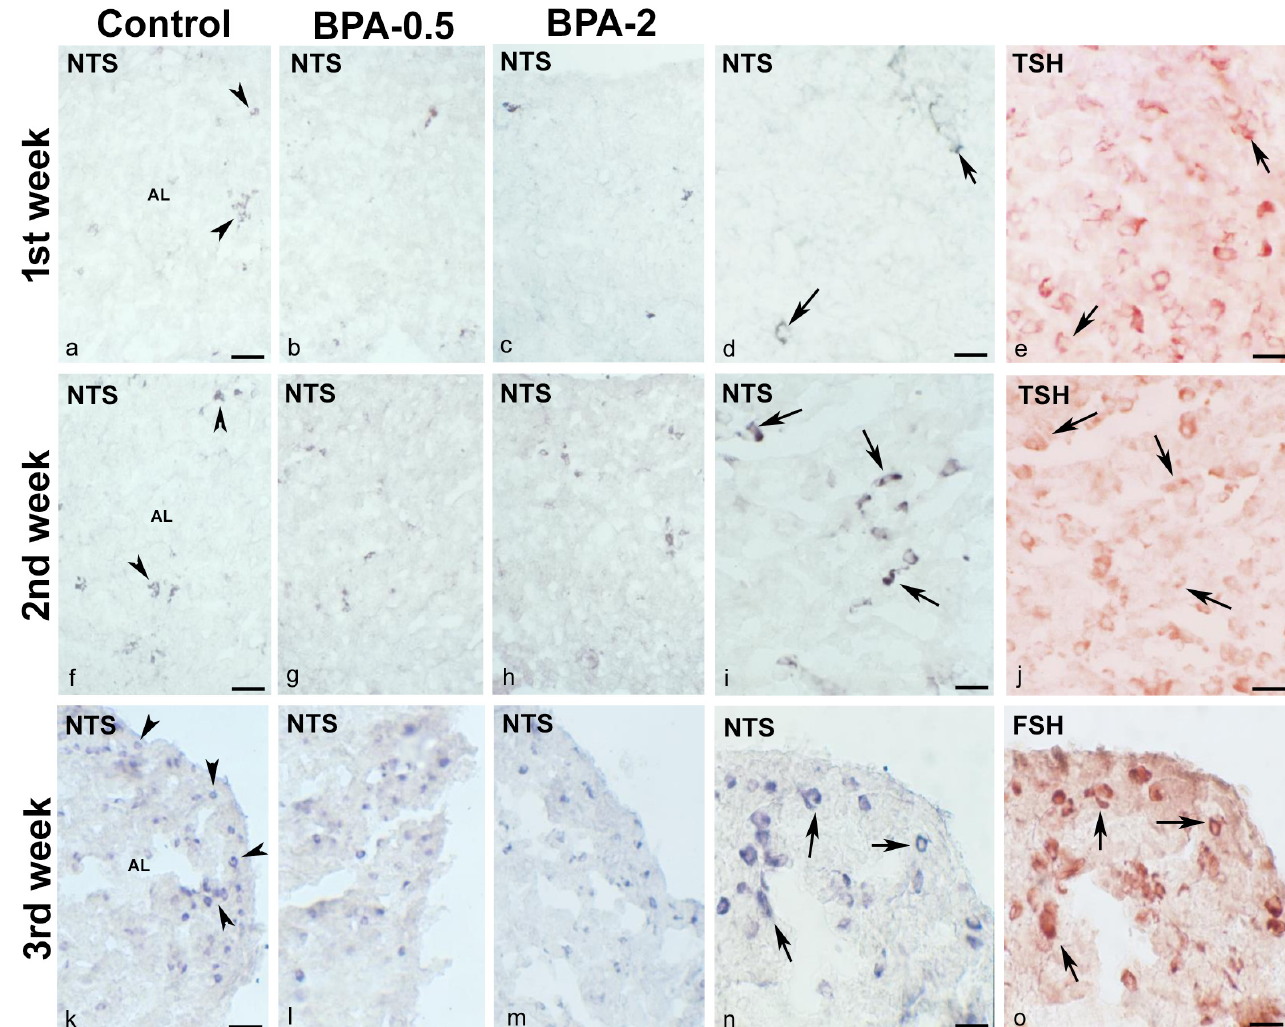
Figure 4. NTS immunoreactivity in offspring pituitary glands. Representative images of the pituitary gland in the first three weeks of postnatal life in the three experimental groups showing the presence of NTS-ir cells (arrowheads) in the central area of the anterior lobe in the 1st ( a – e ) and 2nd ( f – j ) weeks and in the margins of the anterior lobe in the 3rd week ( k – o ). Images ( d , e ) and ( i , j ) show NTS colocalization with TSH (arrows) in the 1st and 2nd weeks in control and BPA-0.5, respectively, and images ( n , o ) show NTS colocalization with FSH (arrows) in the 3rd week in BPA-2. AL: anterior lobe. Scale bars: ( a – c ), ( f – h ), and ( k – m ): 60 µm; ( d , e ), ( i , j ), and ( n , o ): 25 µm. ( a – d ), ( f – i ), and ( k – n ) immunoperoxidase chloronaphthol. ( e , j , o ) immunoperoxidase ethyl carbazole.